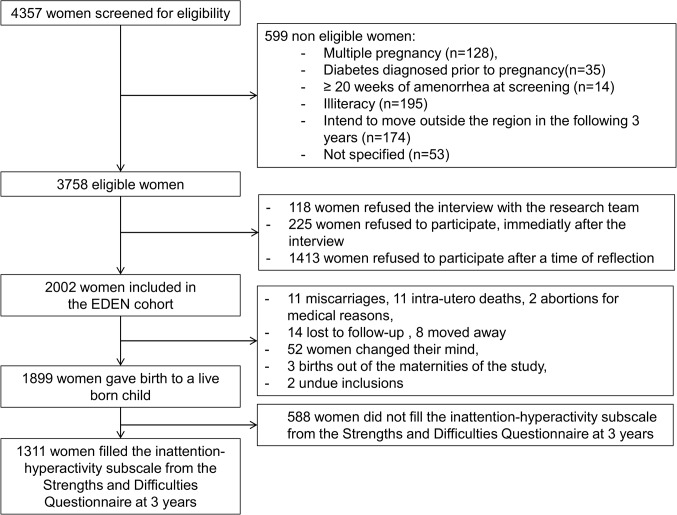
Study population.